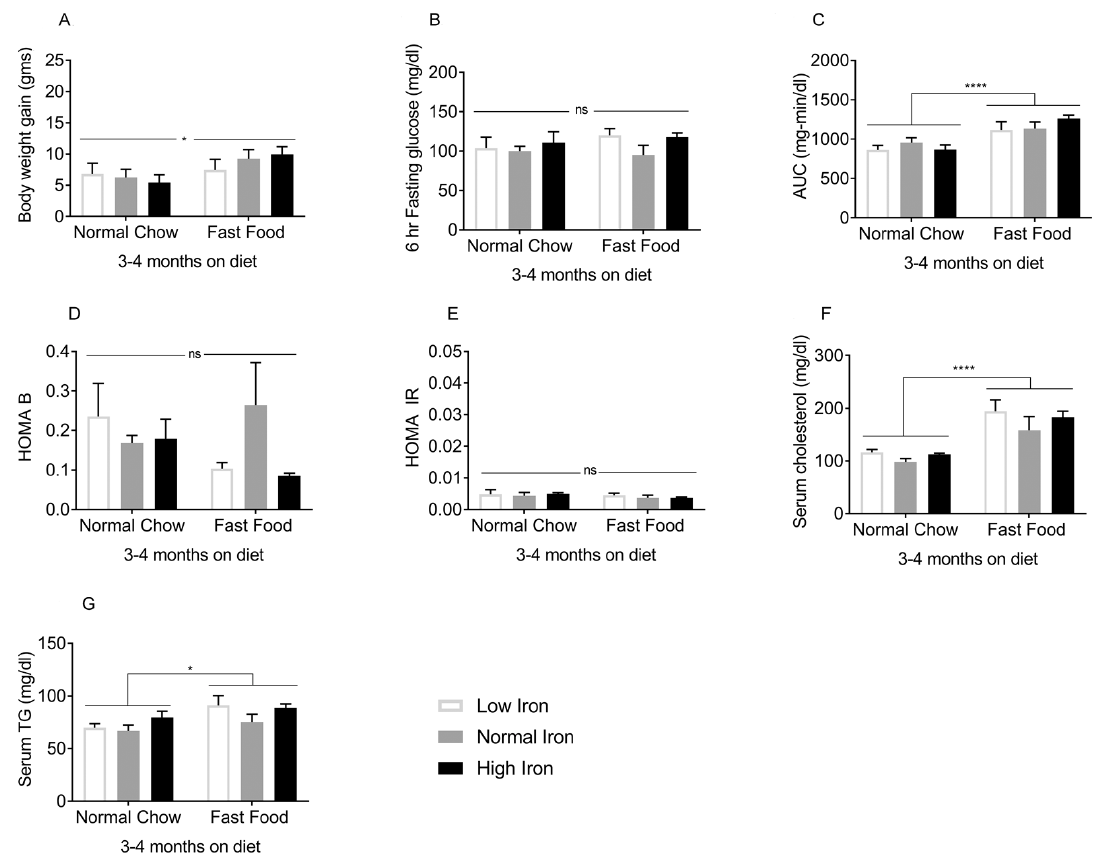
Figure 1. Metabolic phenotypes after 3–4 months on diet: The following were measured in mice on the FF / NC diets for 3–4 months ( n = 3–5 per group). ( A ) Body weight. ( B ) Blood glucose after 6 h fasting. ( C ) Glucose tolerance (area under the glucose curve [AUC] after intra-peritoneal glucose tolerance testing). ( D ) Homeostasis model assessment of β -cell function (HOMA B). ( E ) Homeostasis model assessment of insulin resistance (HOMA IR). ( F ) Serum cholesterol and ( G ) Fasting serum triglycerides (TG). Shown are means ± SE. p values were calculated by two-way ANOVA with post hoc Tukey’s multiple comparisons test. * 0.01 ≤ p ≤ 0.05; **** p < 0.0001, ns: not significant, i.e., p ≥ 0.05.